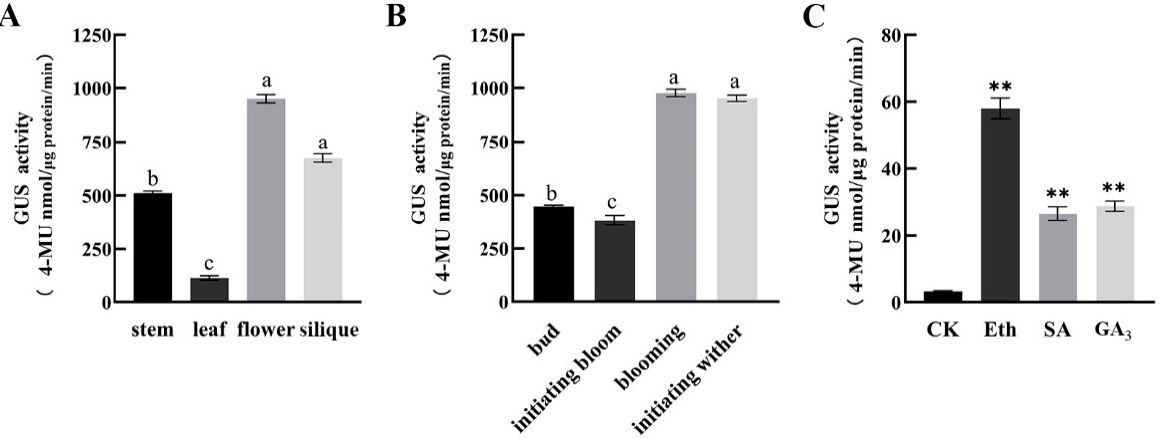
Figure 5. ( A ) GUS enzyme activity in different tissues. ( B ) GUS enzyme activity at different flowering stages. Mean values ( ± standard errors) with different superscript letters (a, b, and c) indicate significant difference ( p < 0.05). ( C ) CpSRG1 promoter activity in response to hormone treatments. CK, ddH 2 O; Eth, ethylene; SA, salicylic acid; GA 3 , gibberellin. Fifteen-day-old T3 homozygous Arabidopsis transgenic seedlings were treated with 50 µ M Eth, 100 µ M SA, 100 µ M GA 3 for 12 h. The plants grown under normal conditions were used as control. Data represent mean of three biological repeats ± SEM. Error bars indicate the standard error of mean. Asterisks denote statistically significant differences compared with control, ** p < 0.01.